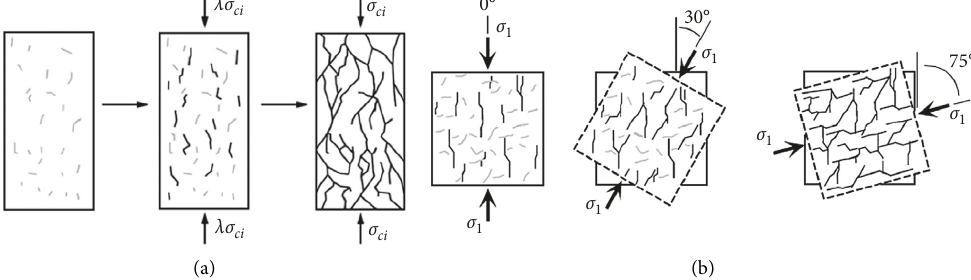
Figure 1: Influence of different stress states on crack propagation. (a) Influence of principal stress ratio on fracture (1 > λ Influence of principal stress direction on fracture [15].